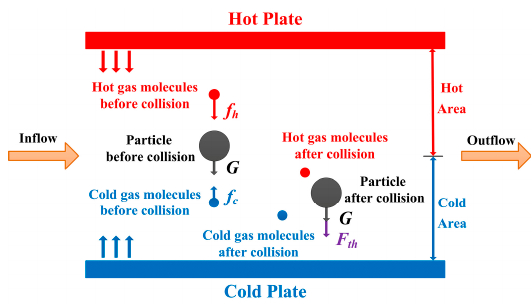
Figure 6. Schematic of the deposition principle of thermophoresis [20].